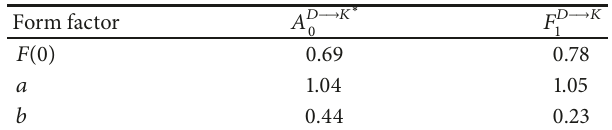
Table 6: The parameters of 𝐷 󳨀→ 𝐾 ∗ ,𝐾 transitions form factors in